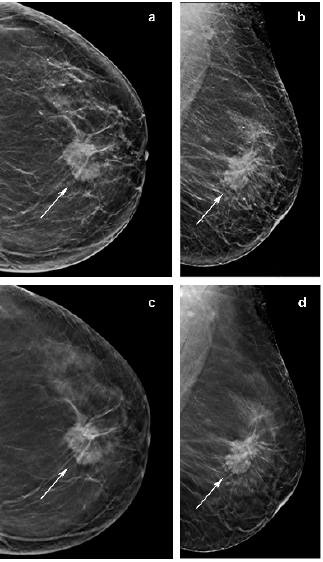
Figure 3. Reader-specific conspicuity. Bar graphs show reader-specific conspicuity evaluation stratified by imaging technique: digital breast tomosynthesis (DBT) or synthesized 2D mammograms (synt2D).